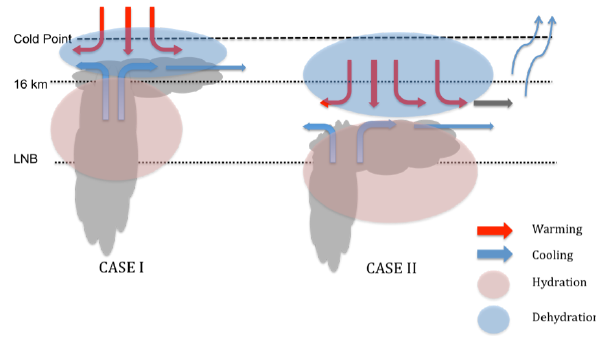
Fig. 10. A schematic of the dehydration and hydration process (including temperature variations) and water vapor transport to the stratosphere above cloud top in the TTL.